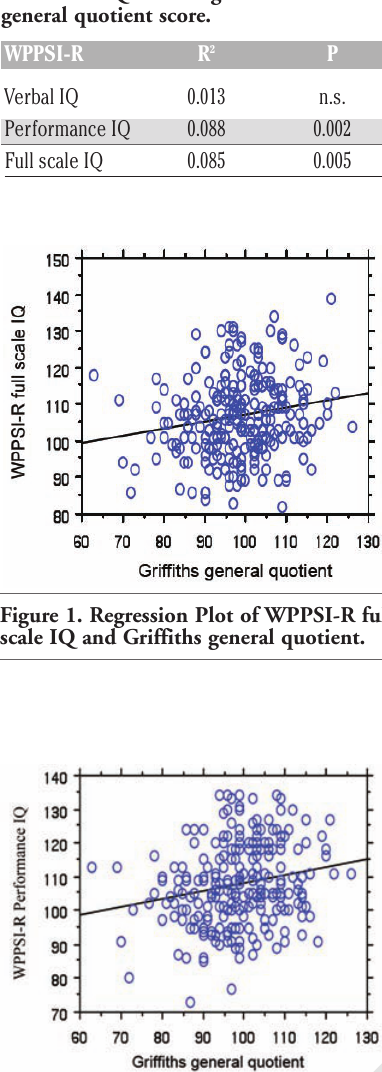
Table 2. Results of ANOVA of Griffiths scales with WPPSI-R full scale IQ. Griffiths scale Mean square